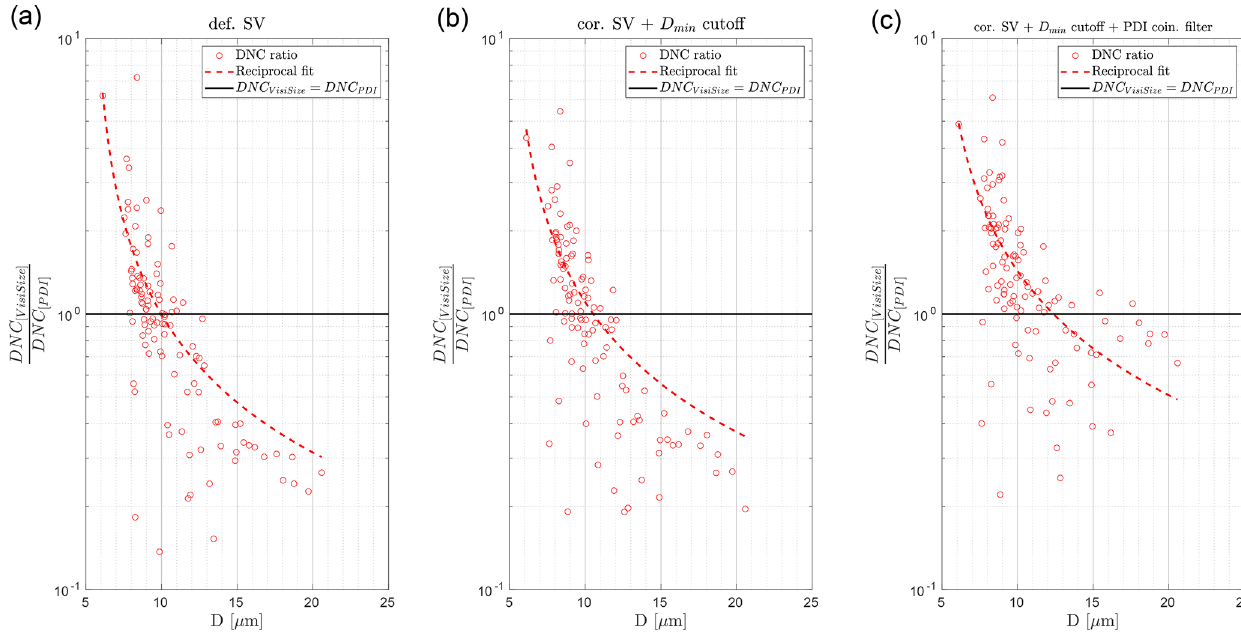
Figure 10. The DNC ratio of the VisiSize to the PVC-PDI as a function of the arithmetic mean diameter size. Panels (a–c) show the raw data (using the default sample volume for the VisiSize), the results after the SV correction and the D min cutoff, and the results after additionally applying the coincidence filter to the PDI data. Each circle represents a single measurement of ∼ 15min. The reciprocal fit curves ( y = a and the 1 : 1 ratio are shown with the dashed and horizontal black lines,